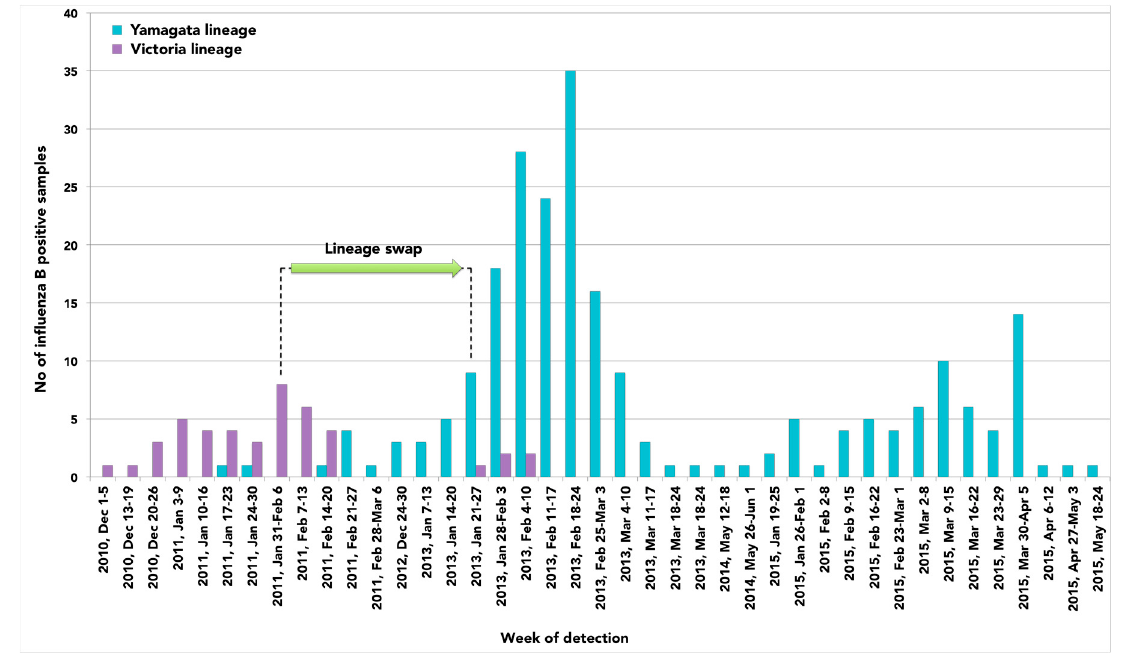
Figure 4. Lineage swap of influenza B viruses occurred in Italy between 2010 and 2015.